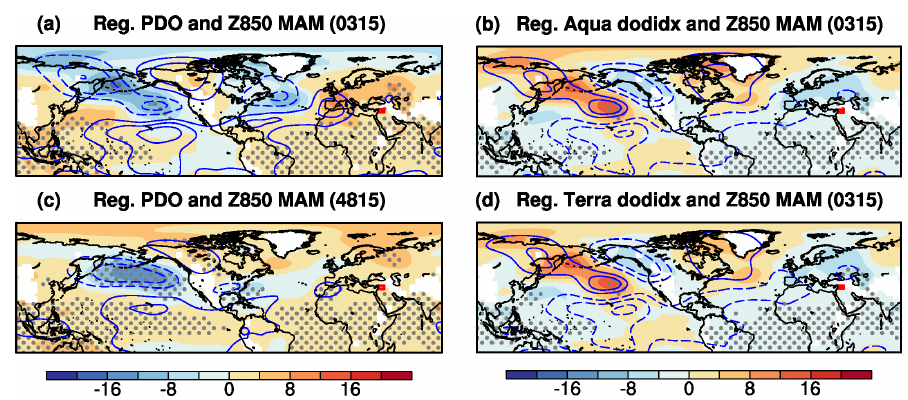
Figure 4. Regression of 850hPa (shading) and 200hPa (blue contours; solid lines for positive values and dashed lines for negative values, from − 40 to 40gpm with an interval of 10gpm, zero line is not shown) geopotential heights onto the standardized PDO index for (a) 2003– 2015 and (c) 1948–2015 and onto the standardized (b) Aqua and (d) Terra DOD indices. Areas significant at the 95% confidence level ( t test) are dotted.